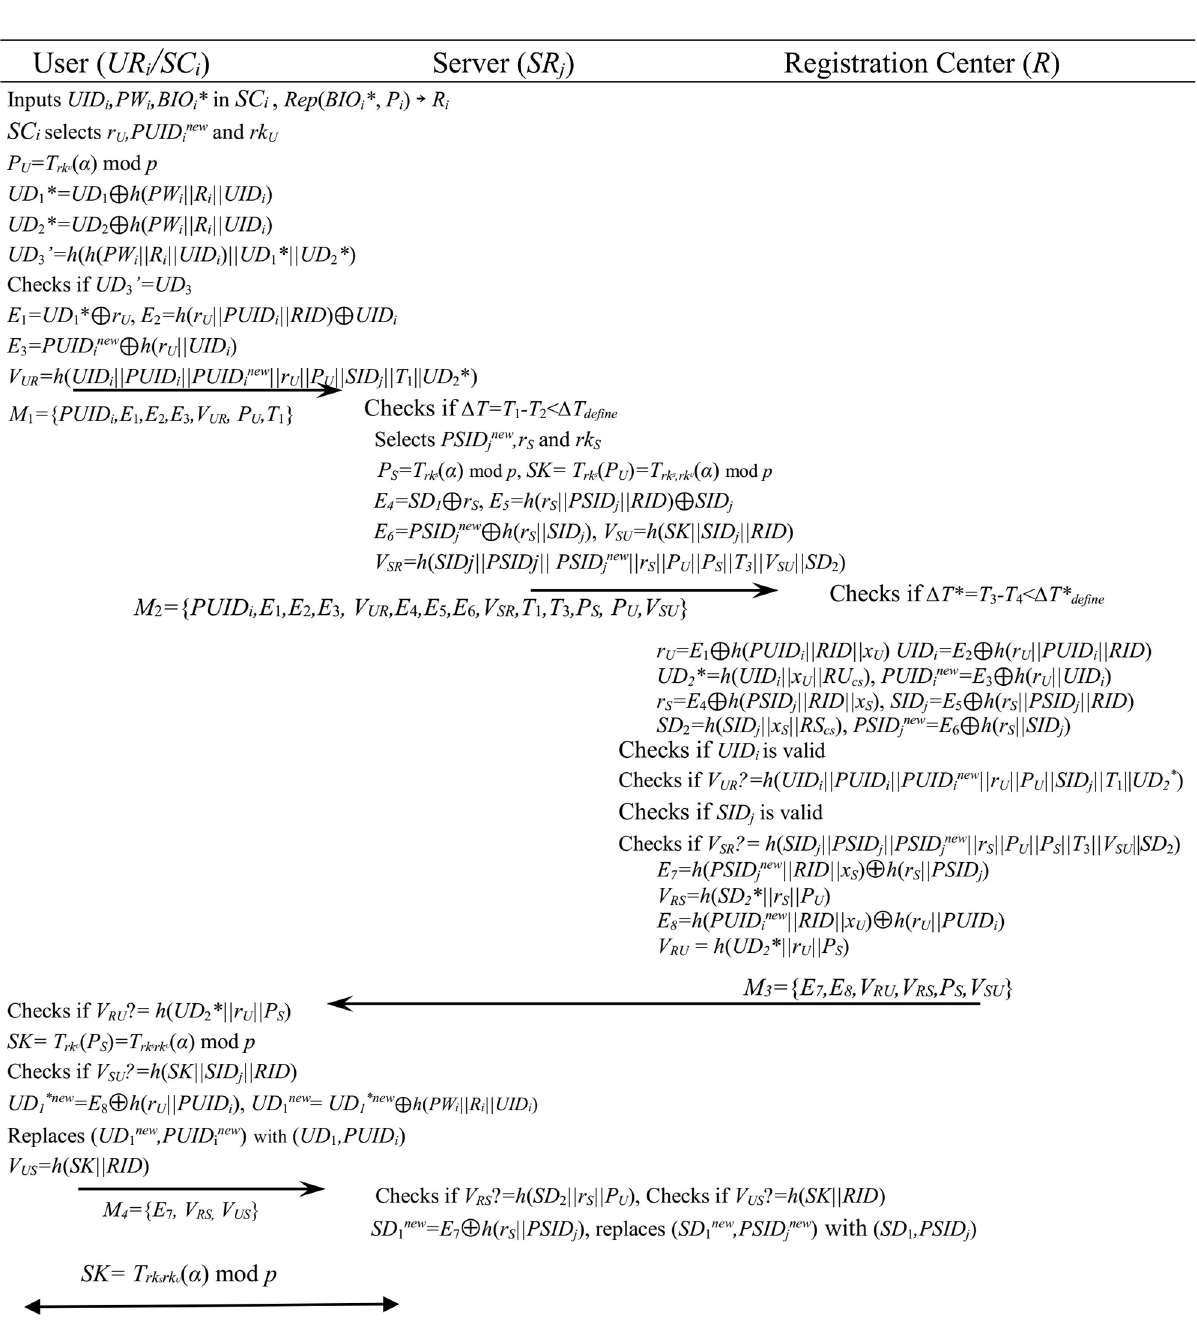
Fig 3. Authentication and session key exchange phase of the proposed